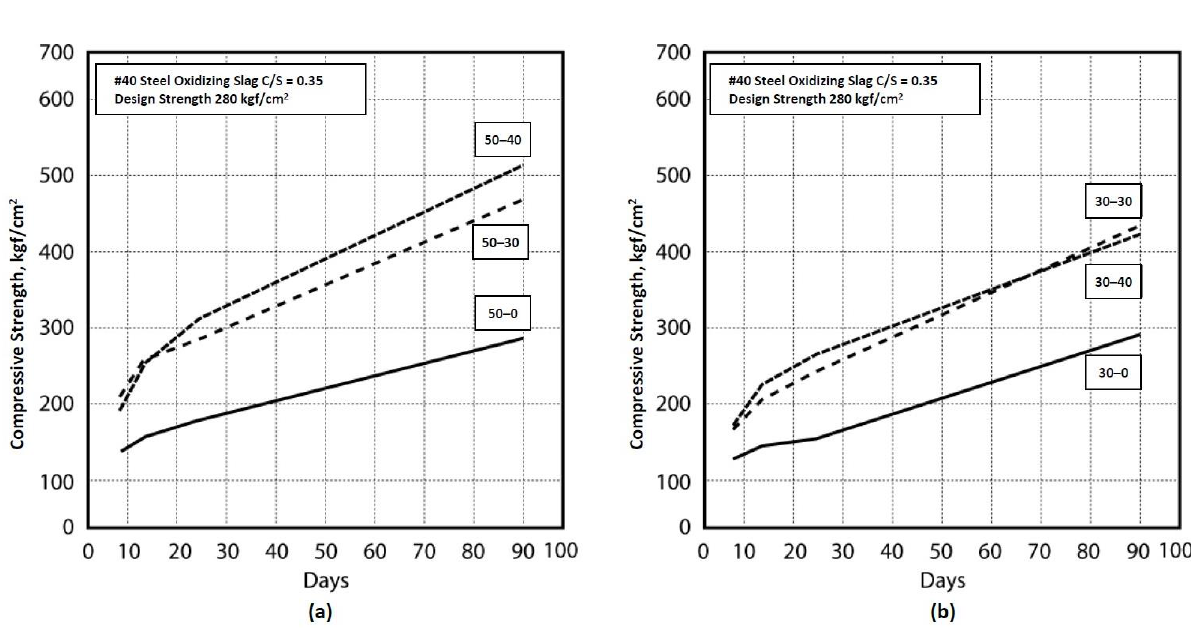
Figure 5. Compressive combination strengths on the 0.35 ratio. ( a ) EAF oxidizing slag adjunction with a percentage of 50%. ( b ) EAF oxidizing slag adjunction with a percentage of 30%.